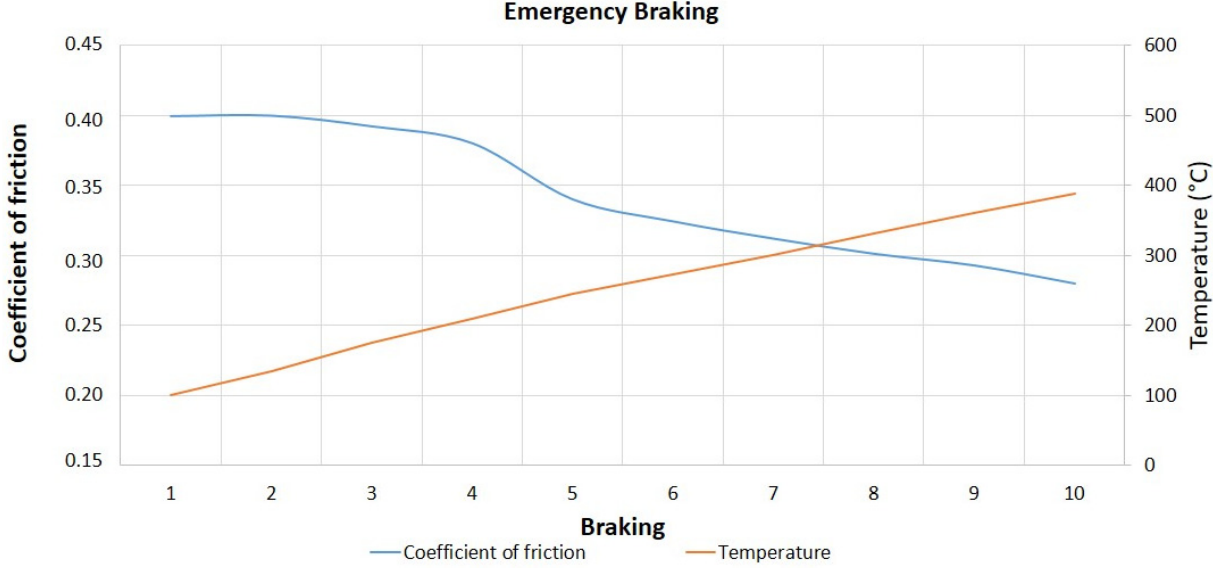
Materials 2021 , 14 , x FOR PEER REVIEW Figure 4. Coefficient of friction and temperature vs. number of brakes— Δ V = 40 Km/h. Figure 4. Coefficient of friction and temperature vs. number of brakes—